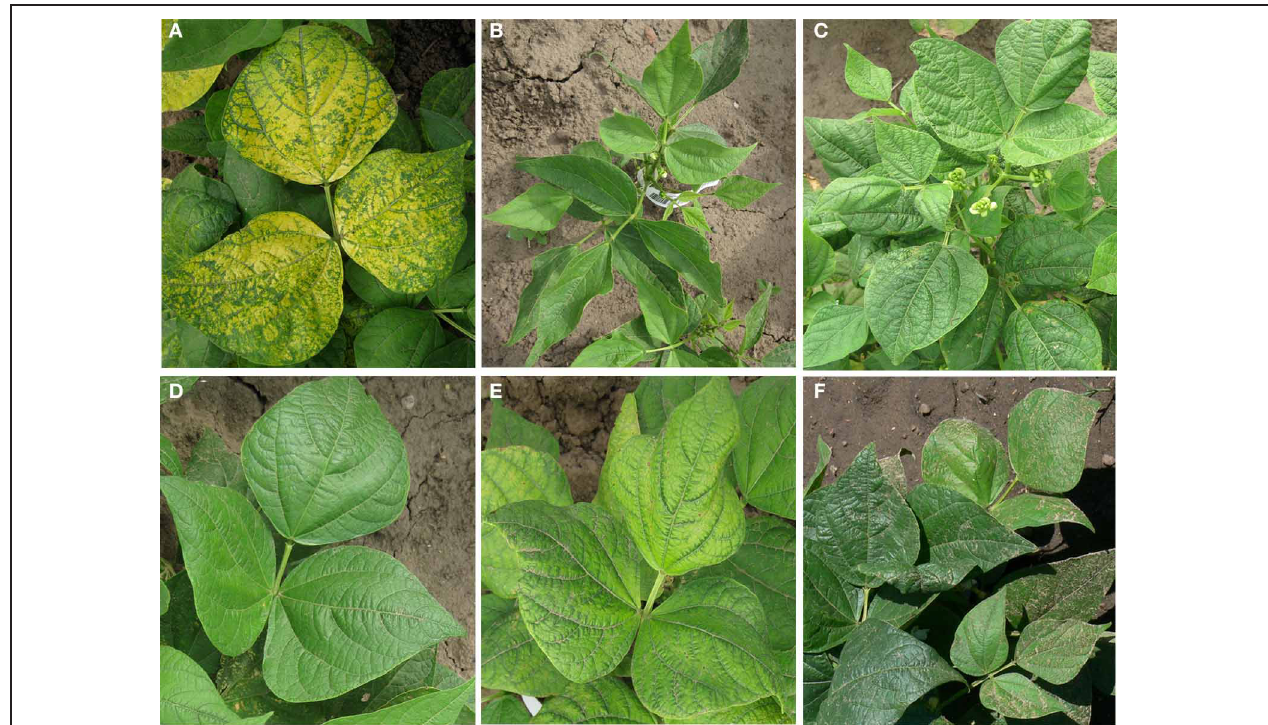
FIGURE 1 | Visual phenotype of five Phaseolus vulgaris cv. Red Hawk mutants from the fast neutron mutant population chosen for DNA-seq. All plants are from the M2 generation and were grown at the University of Minnesota Experiment Station in St. Paul, MN in 2011. (A) Mutant 1R5C01r5CPVMN11 referred to as decorative due to the chlorotic patterning on leaves early in the growing season. (B) Mutant 1R19C15r28CPVMN11 referred to as lanceolate due to the elongated shape of the leaf. This mutant also appeared shorter than the WT